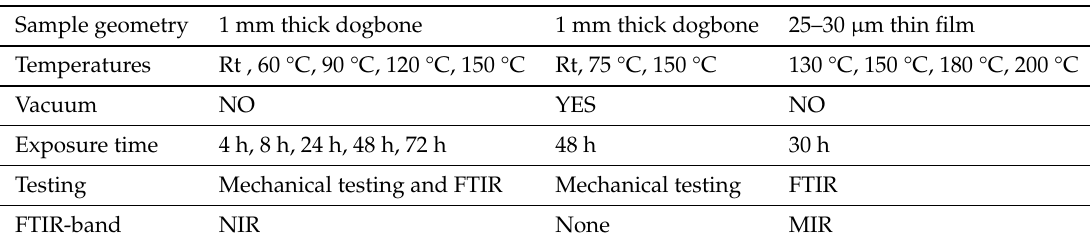
Table 1. Overall thermal exposure time overview. FTIR, Fourier-transform infrared spectroscopy; NIR, Near-IR; MIR,